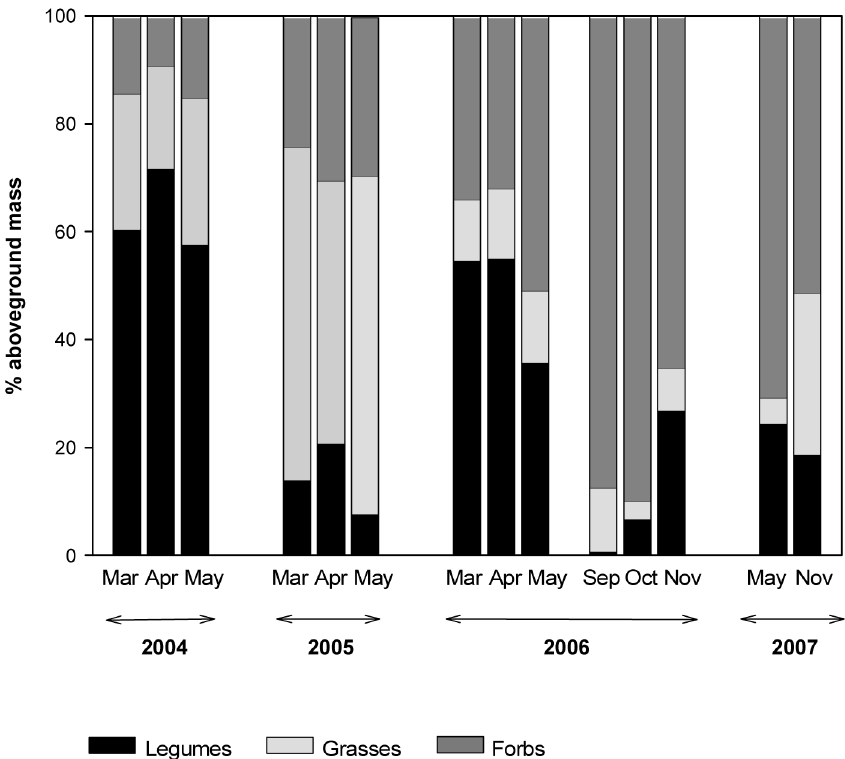
Fig. 2. Inter-annual changes in the proportion of legumes, grasses and forbs over the total aboveground plant